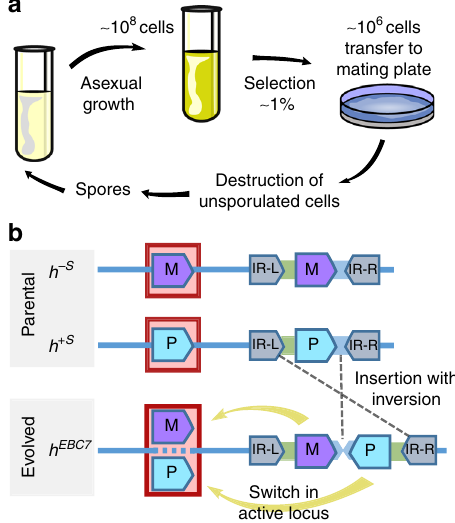
Fig. 2 Experimental evolution of switching. a Sequence of events during one experimental cycle: (1) 2 days of asexual growth to saturation. (2) Transfer of 1% of the cells to a nitrogen-de fi cient medium. (3) Killing of non-mated haploid and unsporulated diploid cells with enzyme treatment and ethanol. (4) Transfer of sexual spores to a fresh medium for asexual growth. b Mating-type con fi guration of parental strains used in the experiment (top) with non-switching phenotype ( h – S and h + S ), and con fi guration of the long- read sequenced-evolved switching strain (EBC7; bottom) with an active mat1 locus indicated by the red box. The evolved strain contains an additional mating-type cassette, which allows the strain to switch between P and